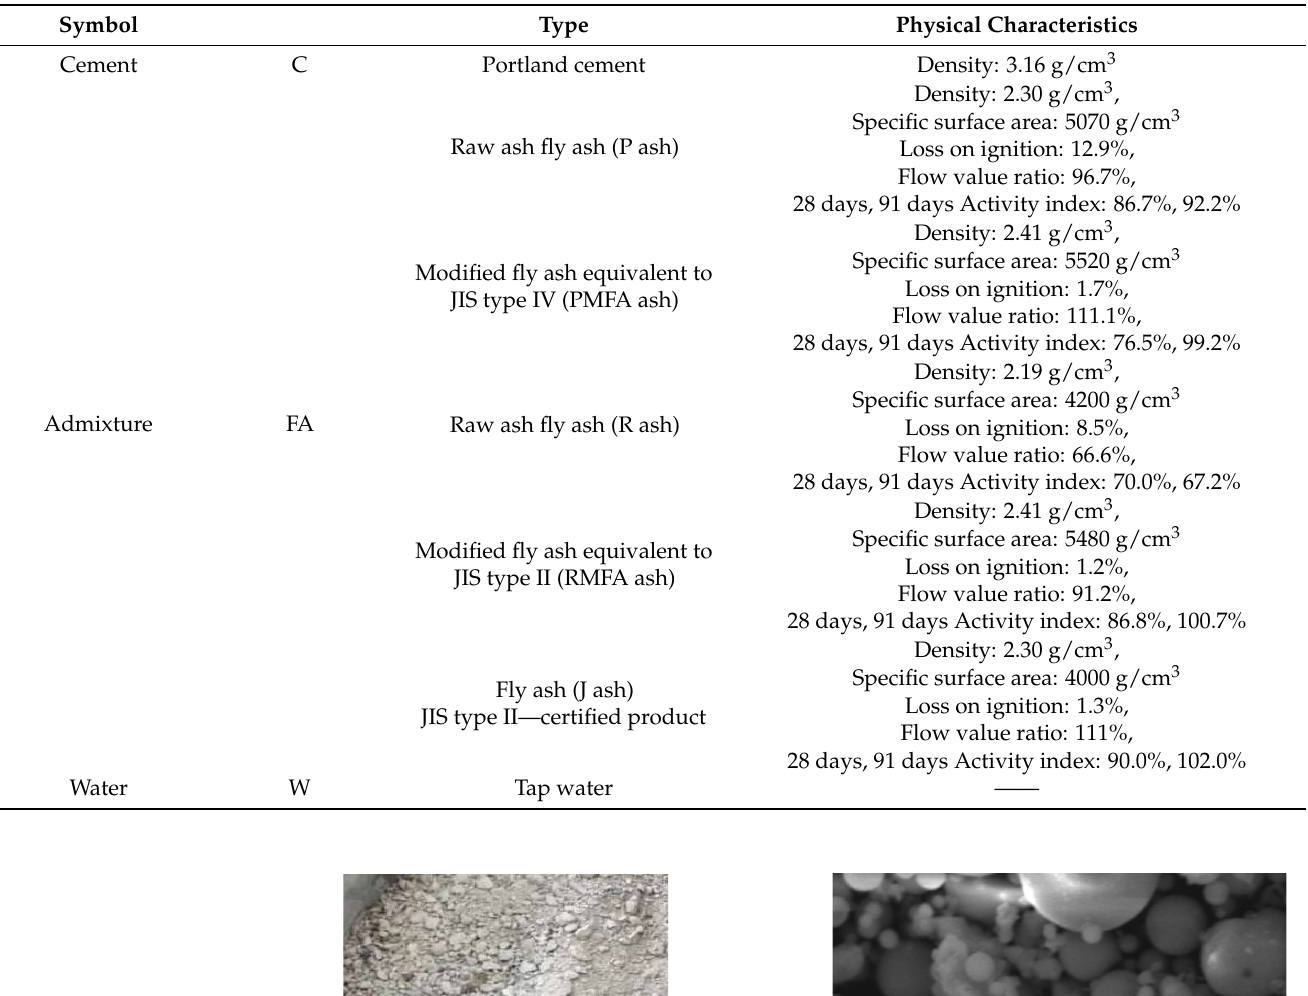
Table 2. Materials.